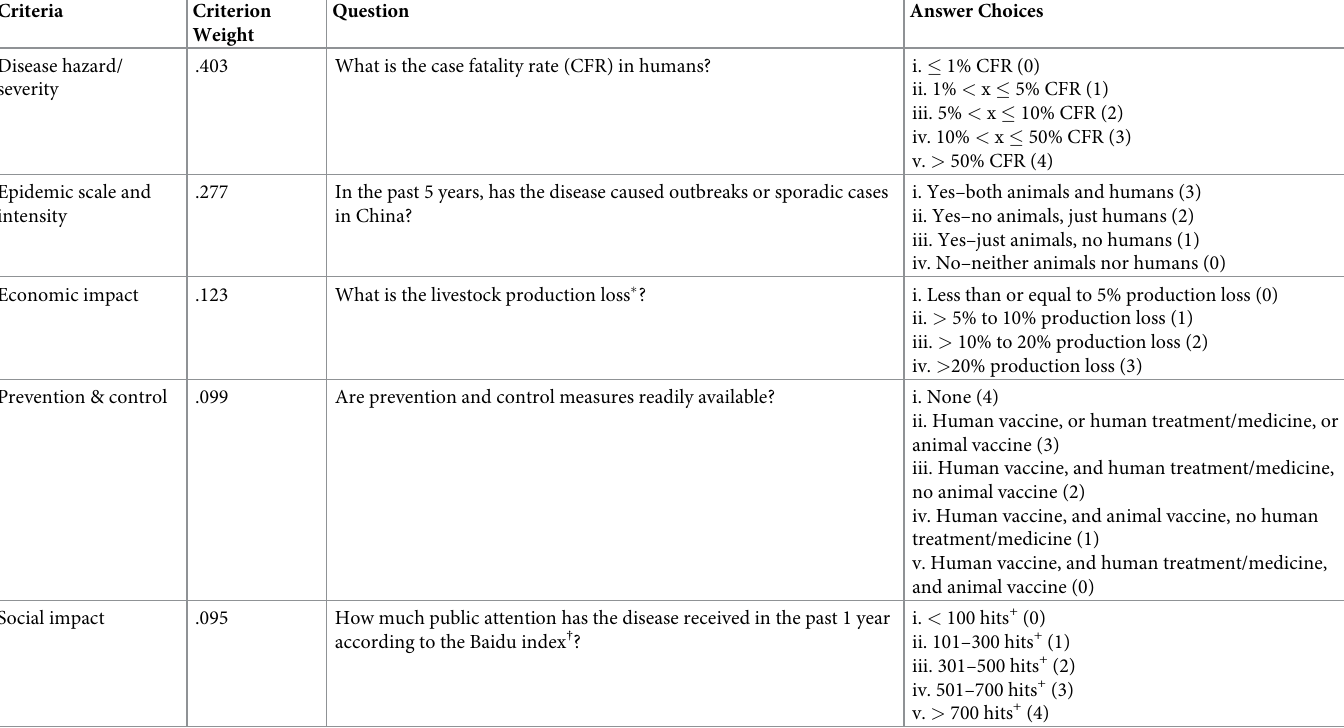
Table 3. Criteria, criterion weights, questions, and answer choices selected by workshop participants, Beijing, China, May 15–17,